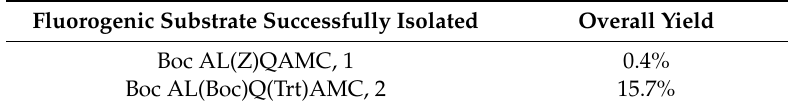
Table 2. Fluorogenic substrates successfully isolated and their overall percentage yields.